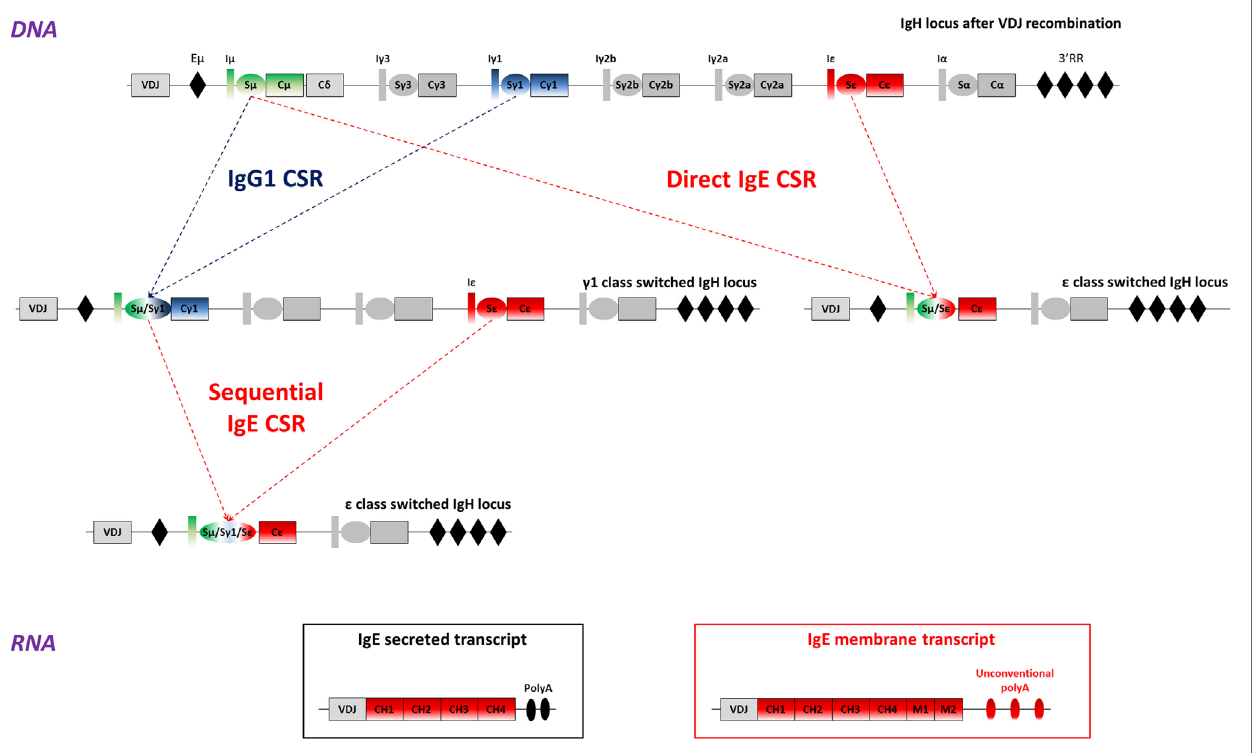
FigURe 1 | IgE class switch recombination, secreted, and membrane IgE (mIgE) transcripts. Top: mouse WT IgH locus is represented after VDJ recombination (not to scale). The recombined VDJ gene and constant (C) genes are represented as outlined boxes. I exons (I) and switch (S) regions preceding each constant gene (excepted C δ ) are represented as boxes and ovals, respectively. Black diamonds portray important regulatory elements: the intronic enhancer μ (E μ ), and the super-enhancer 3 ′ regulatory region (3 ′ RR). Upper-middle: after B-cell activation, activation-induced deaminase (AID) is expressed and exerts its mutagenic activity on the VDJ gene, allowing production of antibodies with increased affinity for the Ag. AID is also targeted to S regions to initiate DNA double strand breaks, thereby inducing class switch recombination (CSR) between two S regions, here S μ and S γ 1, or S μ and S ε . This process allows the production of high-affinity IgG 1 antibodies, or low-affinity IgE. Lower-middle: cells can undergo more rounds of cell cycle or re-express AID after re-exposure to antigen and undergo a sequential CSR event, from γ 1 to ε here, to produce high-affinity IgE antibodies. Bottom: IgE class-switched cells produce two main transcripts: mIgE transcripts including the four constant exons (CH1 to CH4), the two membrane (M1 and M2) anchor domains and unconventional polyadenylation (polyA) signals and/or secreted IgE transcripts, containing the constant genes and two conventional polyA signals. Alternate IgE transcripts have been described and could contribute to IgE response regulation.